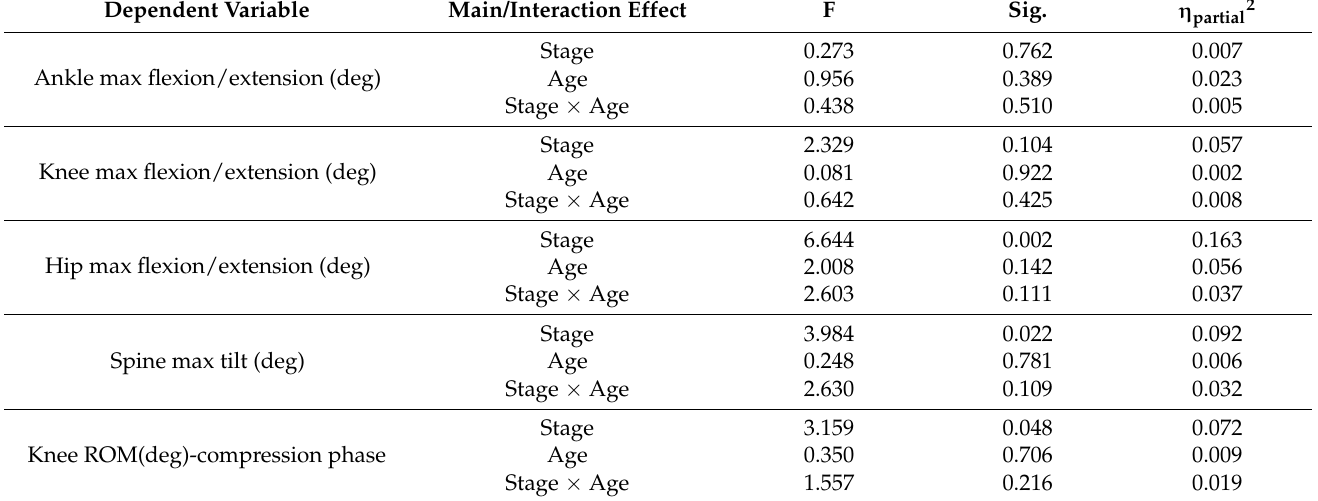
Table 4. Results of main and interaction effect of joint angle and angular velocity parameters.